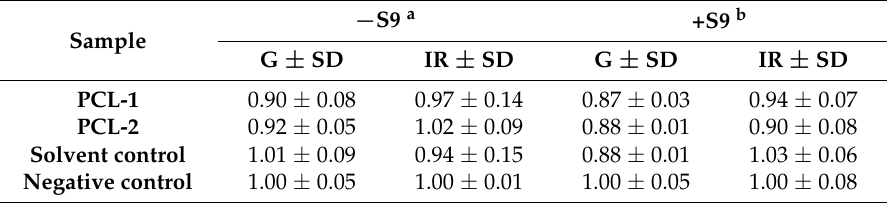
Table 2. The umu -test results for the highest concentrations of tested extracts (0.67 mg · mL − 1 ). Sample